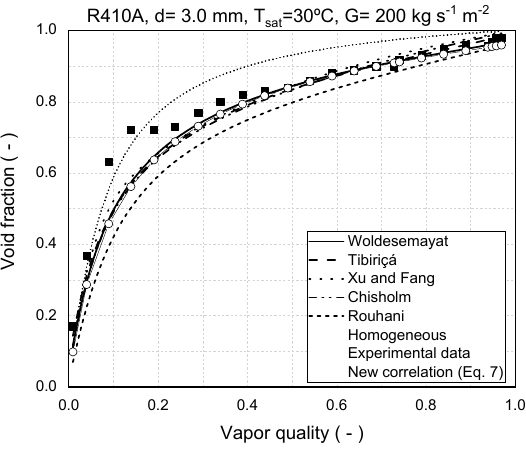
Figure 9. Comparison between experimental data of Portillo [27] and correlations predicted data.